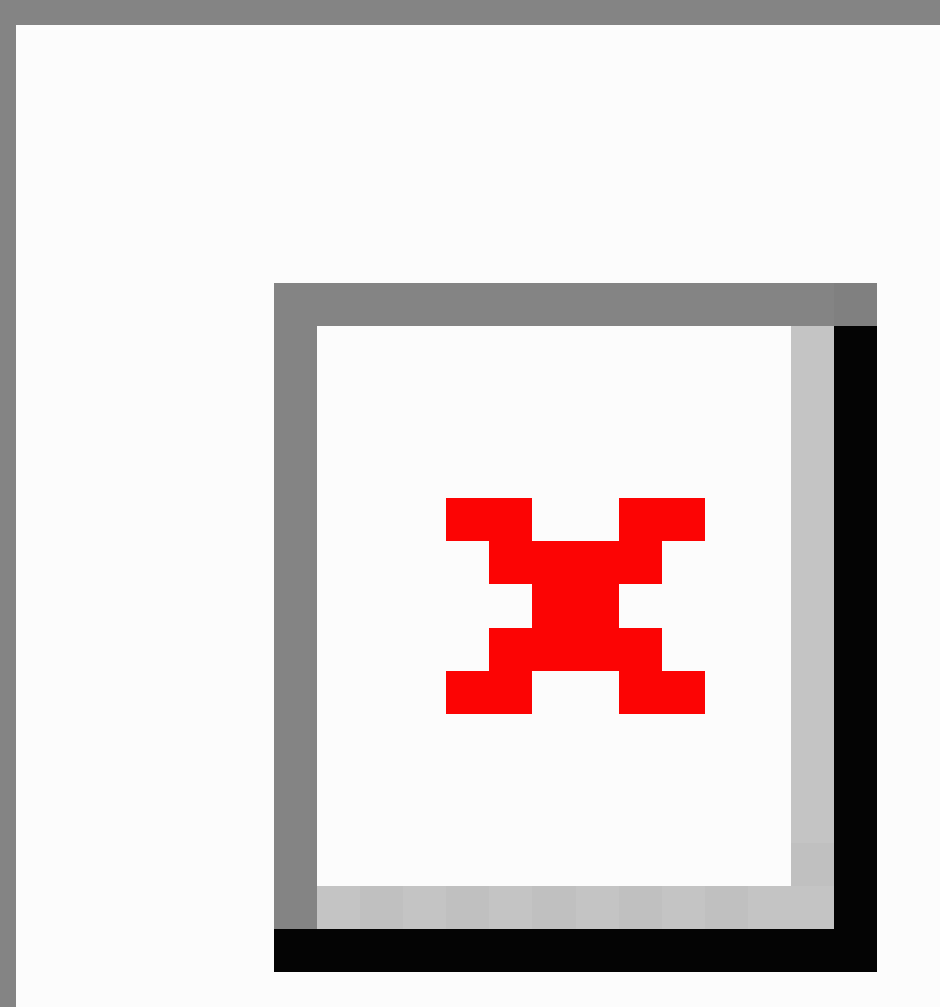
Figure 2. Effect of the intervention on selected parameters in the different study